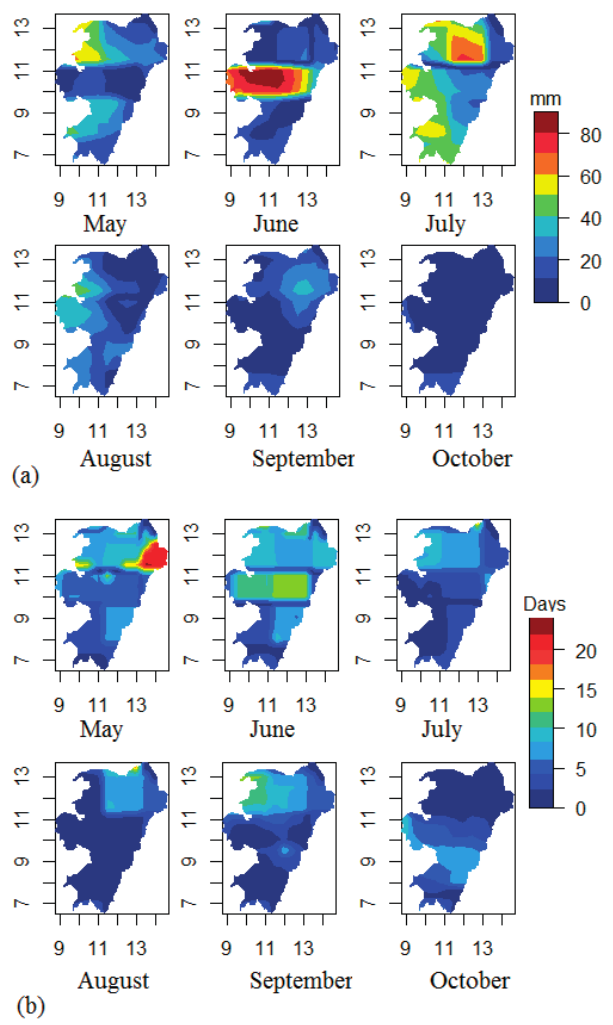
Figure 5. RMSE between the 24-month NCEP-CRU and 24-month predictions of ( a ) monthly rainfall in mm and ( b ) the frequency of the number of rain days in a month (in days) from May–October. The axes show the latitude and longitude coordinates in degrees.